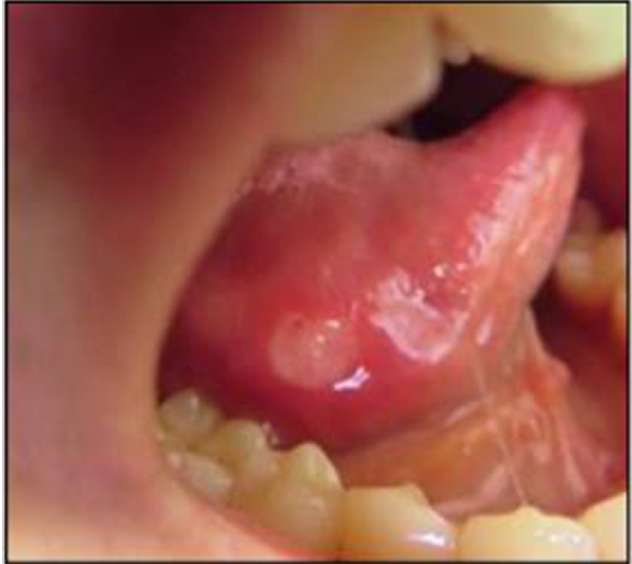
Fig.1. Everolimus-induced mucositis localized in the lateral aspect of the